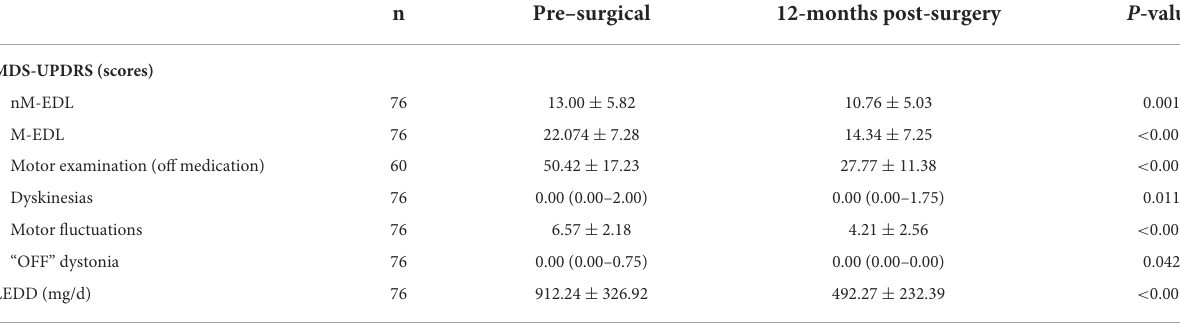
TABLE 4 Improvements in 76 patients with PD 12 months